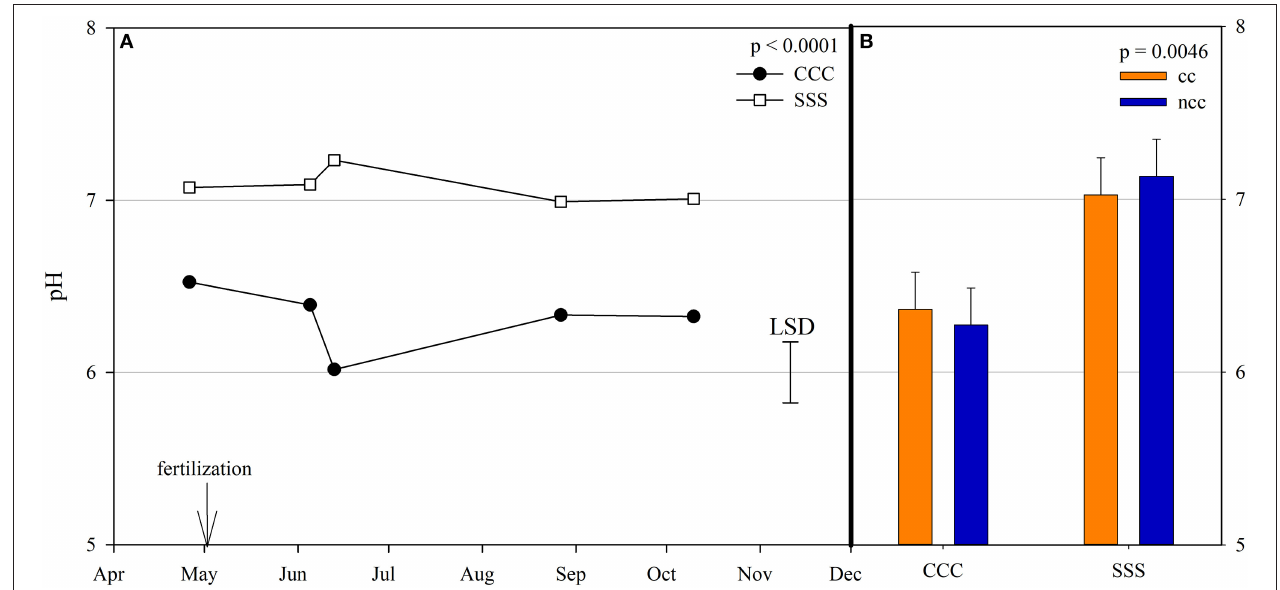
FIGURE 4 | (A) Mean soil pH values throughout the 2019 growing season separated by crop rotation [CCC, continuous corn (circles); SSS, continuous soybean (squares)]. Significant differences in treatment means can be interpreted by the Least Square Differences (LSD) error bar to the right of the figure. Mean values that fall beyond the distance of the LSD are significant at α = 0.10. (B) mean soil pH values separated by cover crop [CC, cover crop (orange); NCC, no cover crop (blue)] and crop rotation [CCC, continuous corn; SSS, continuous soybean]. Error bars above each main bar represent standard errors of the mean PC scores. Differences are significant at α = 0.10.